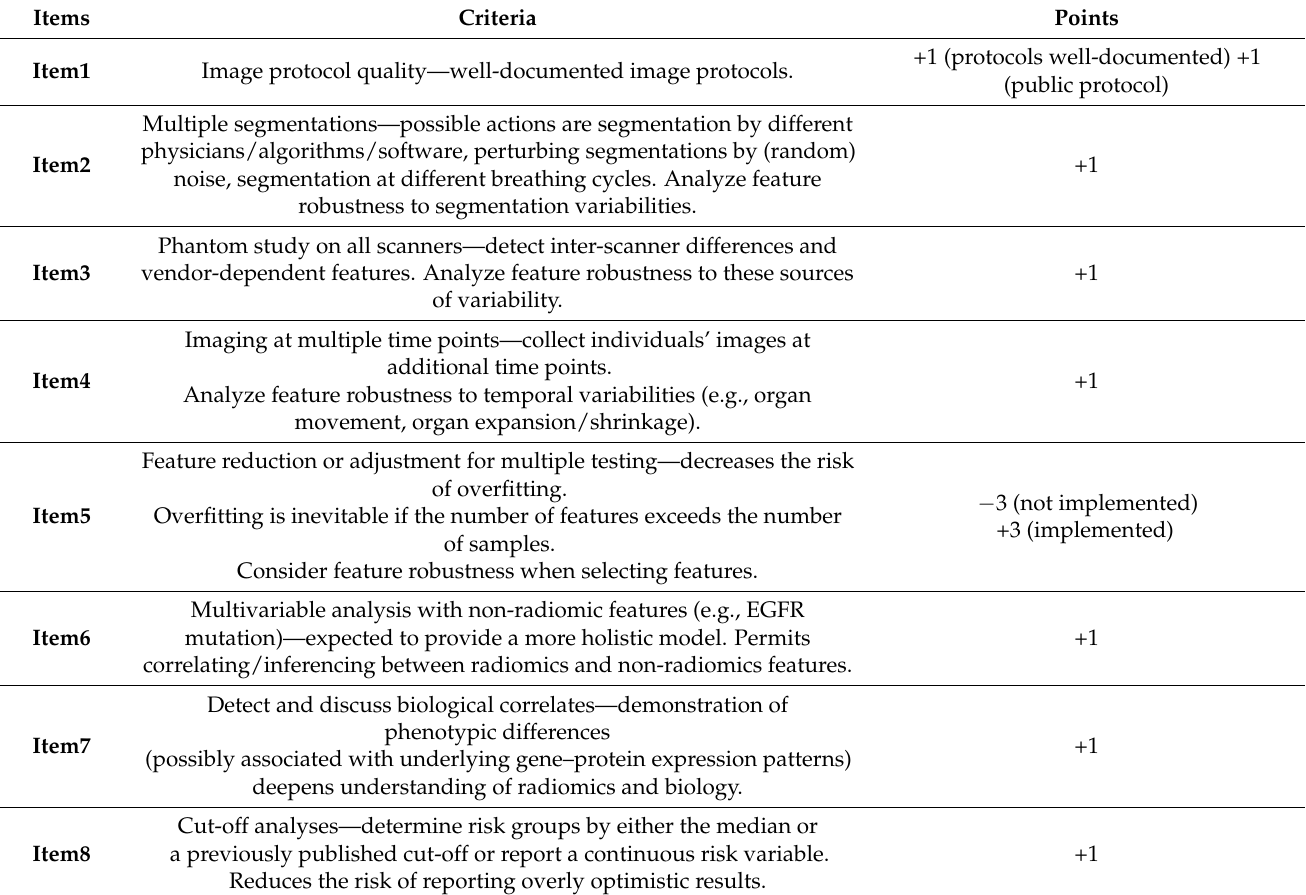
Table 1. Overview of RQS items, criteria and